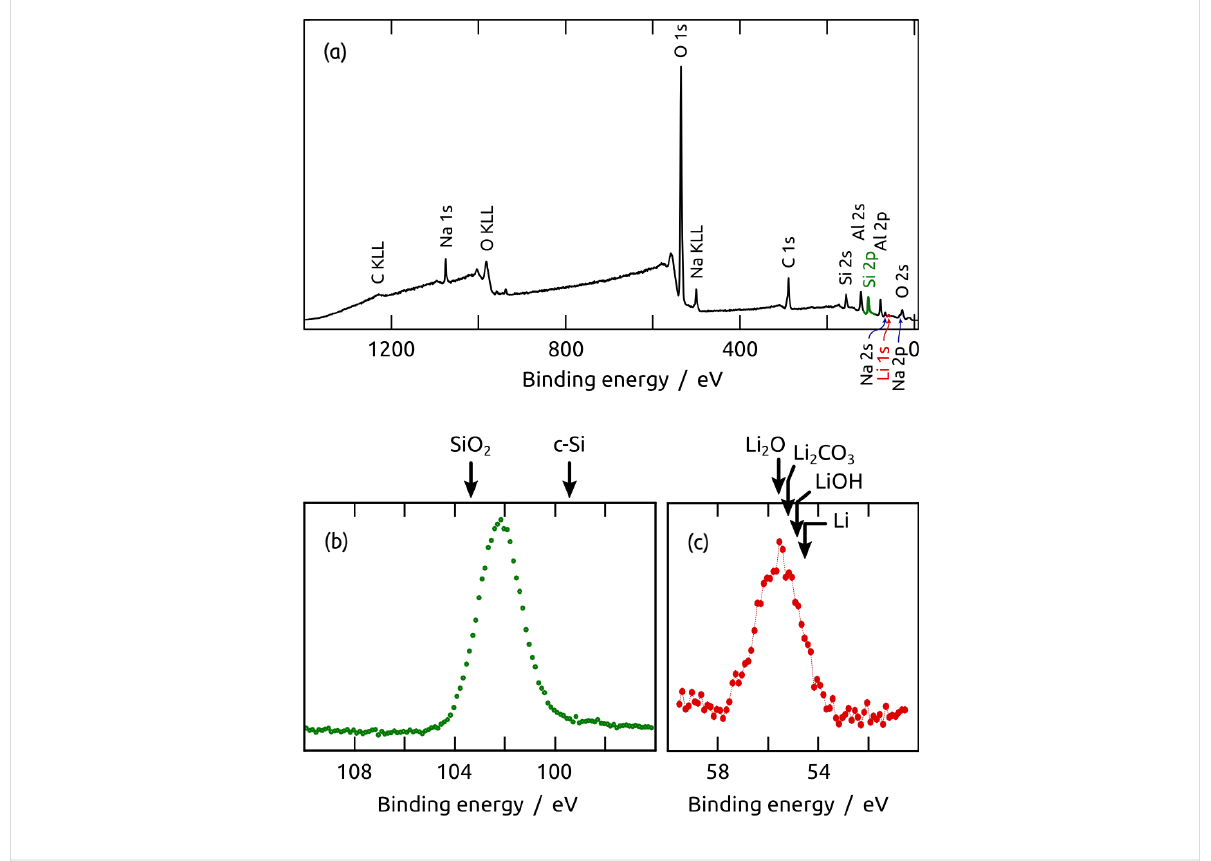
Figure 6: X-ray photoelectron spectrum of a Si nanotube sample at the end of the preparation: (a) survey spectrum, (b) Si 2p peak, and (c) Li 1s peak. The XPS peak positions of reference compounds are given by